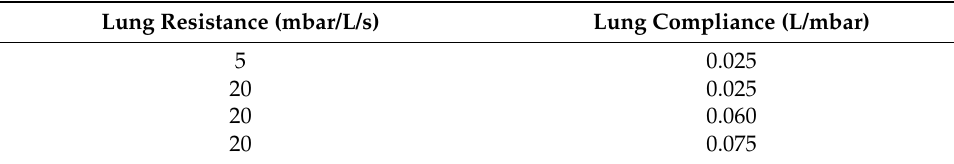
Table 8. Performance testing condition of pressure-control ventilator.